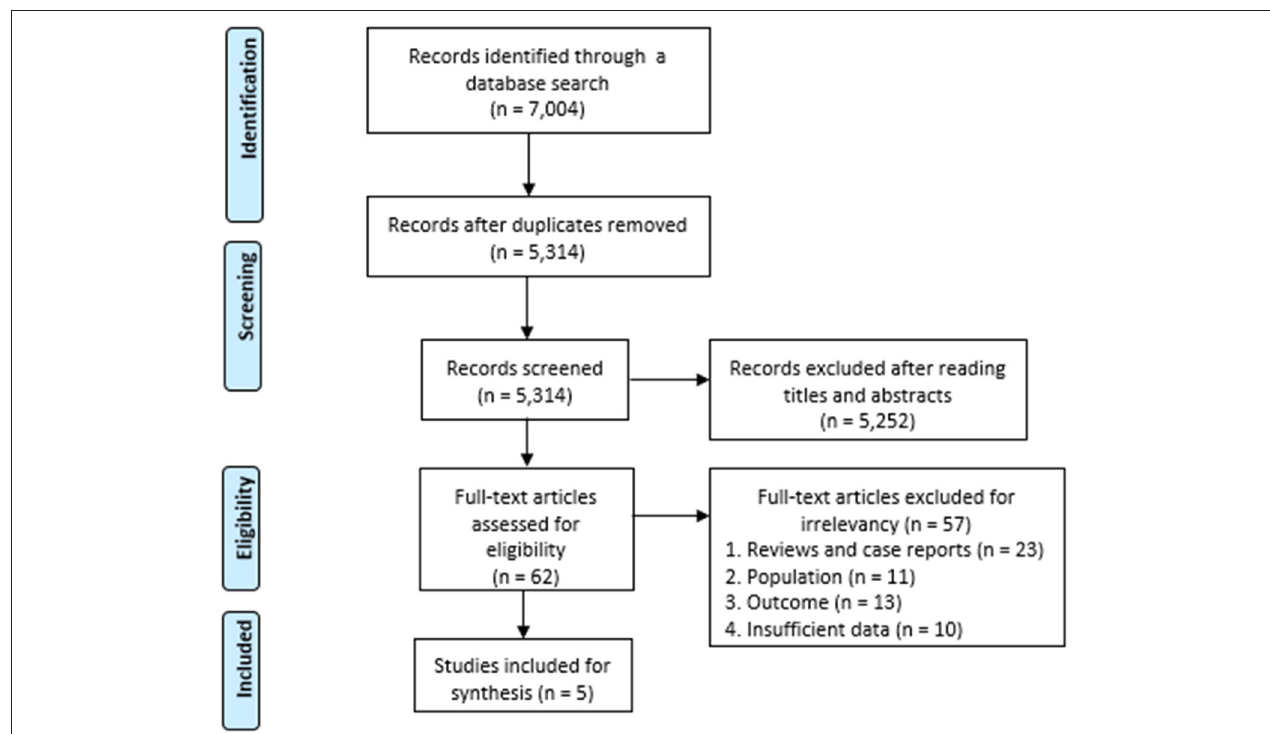
FIGURE 1 | PRISMA flow